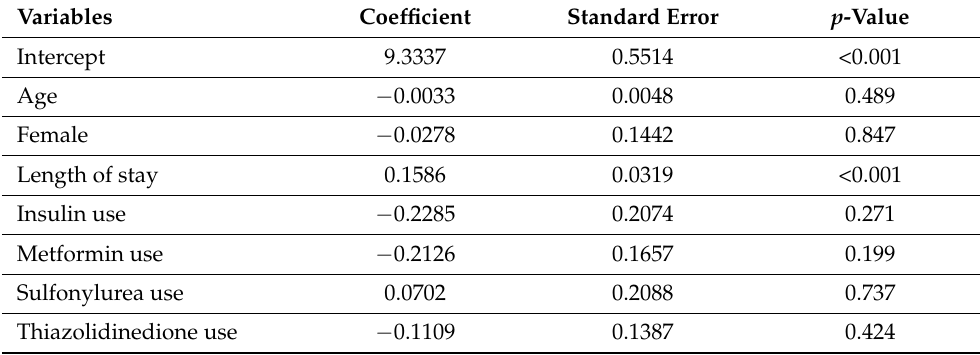
Table 5. Baseline predictors of the total cost of inpatient visits in a multivariate